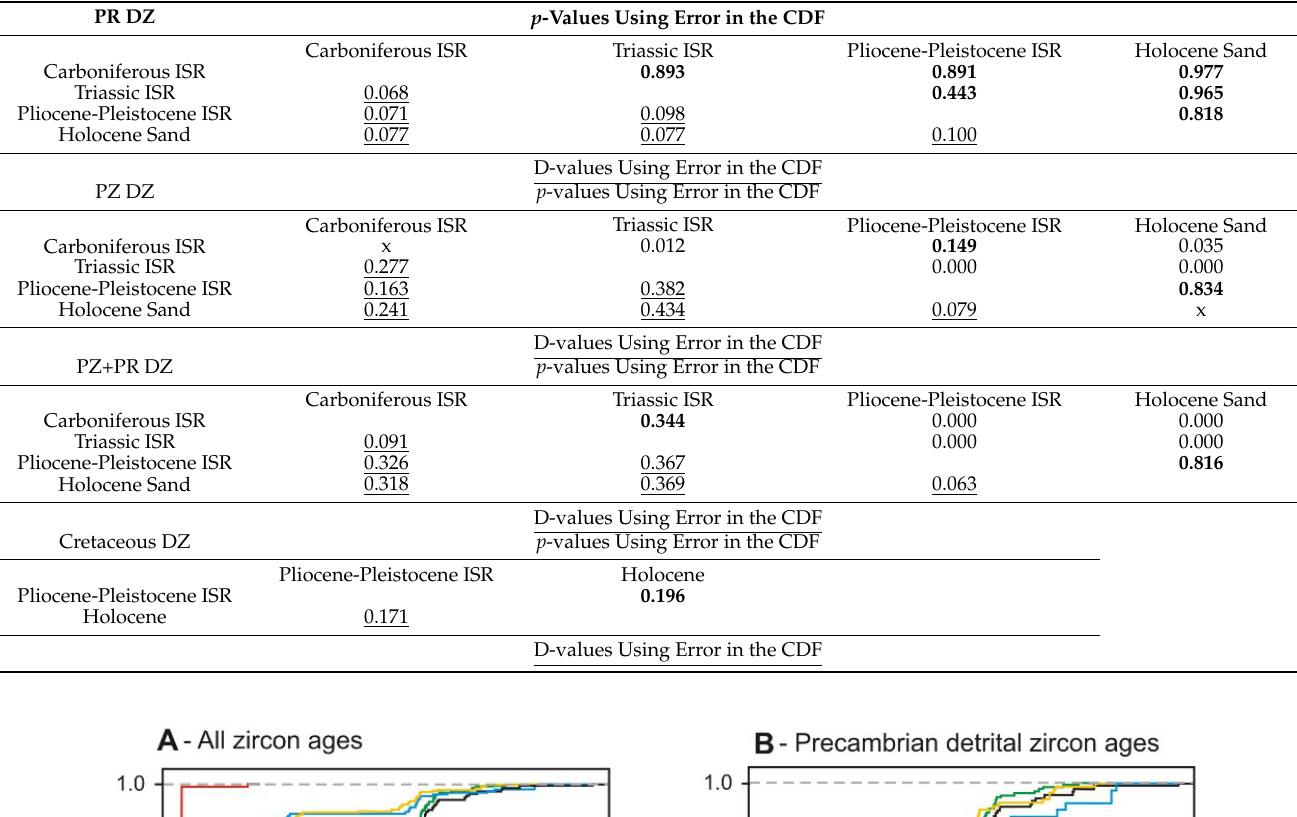
Table 2. Results of the Kolmogorov–Smirnov (K–S) test of the detrital zircon distribution ages of the Carboniferous, Tri- assic, and Pliocene-Pleistocene siliciclastic rocks, as well as Holocene beach sand (U–Pb data from [16,28,29,34,39,40]). Age intervals are based on LA-ICP-MS results with 90–110% concordance. DZ = Detrital zircon. Age groups: PR = Precambrian zircon, PZ = Paleozoic zircon, and PZ + PR = combination of Paleozoic and Precambrian zircon. ISR = intermediate sedi- ment repository. The probability of the observed D-value being unrelated to age differences between the two populations or age groups is given by a p -value corresponding to a confidence interval of 95% [21], with high D-values and low p -values indicating that the observed difference between the two populations or age groups may be explained by distinct sources [43]. Numbers in bold with a p -value > 0.05 indicate zircon populations or age groups that are not significantly different; D-values using error in the CDF are indicated by underlined values.